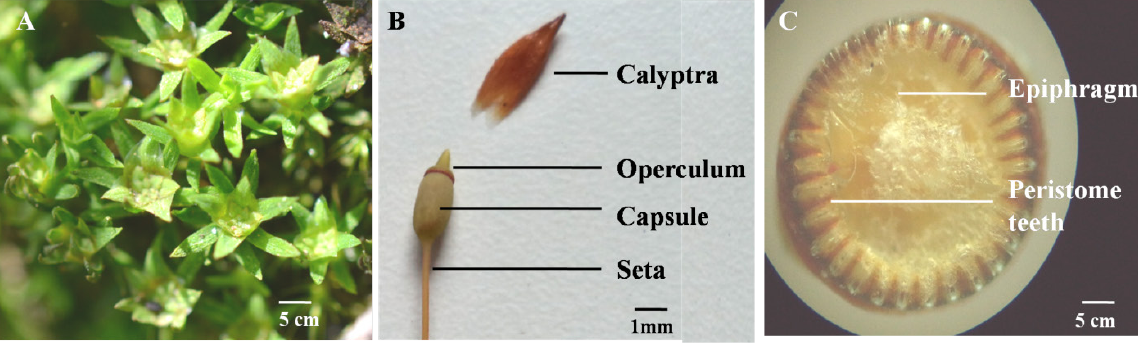
Figure 2: Reproductive characters of Polytrichaceae (A) perigonia of Pogonatum aloides (B) capsule of P. neesii (C) epiphragm of P.